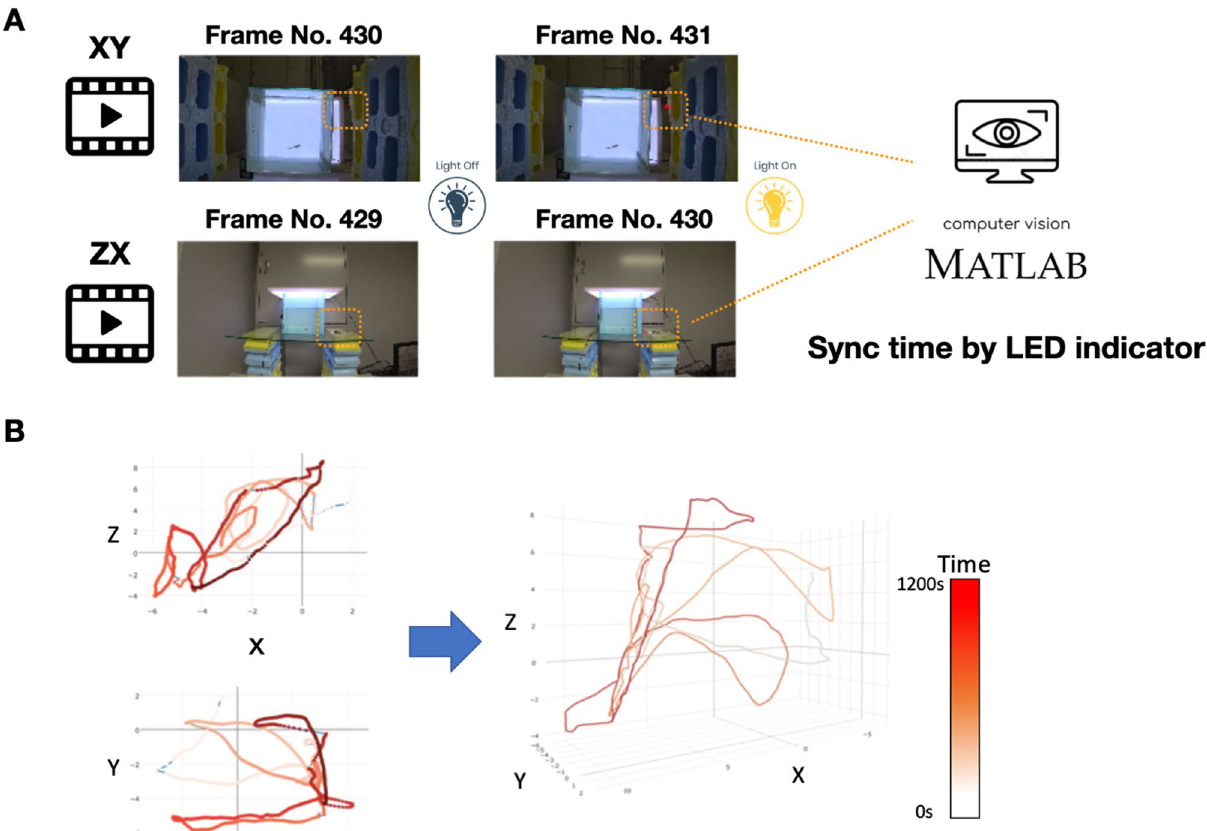
Figure 3. Camera time synchronization and swim path reconstructions in adult zebrafish. ( A ) Animal behavior was manually observed, two cameras recorded the videos, and the time lag between two videos (ventral and lateral) was synchronized by an LED indicator. At the beginning of the experiment, the LED indicator was automatically turned on by Arduino. The experiment’s beginning frame of each video was detected via a computer vision analysis by a customized MATLAB program to ensure the accuracy of behavioral spatiotemporal data. ( B ) After time synchronization, 3D swimming path reconstruction was performed using a customized R